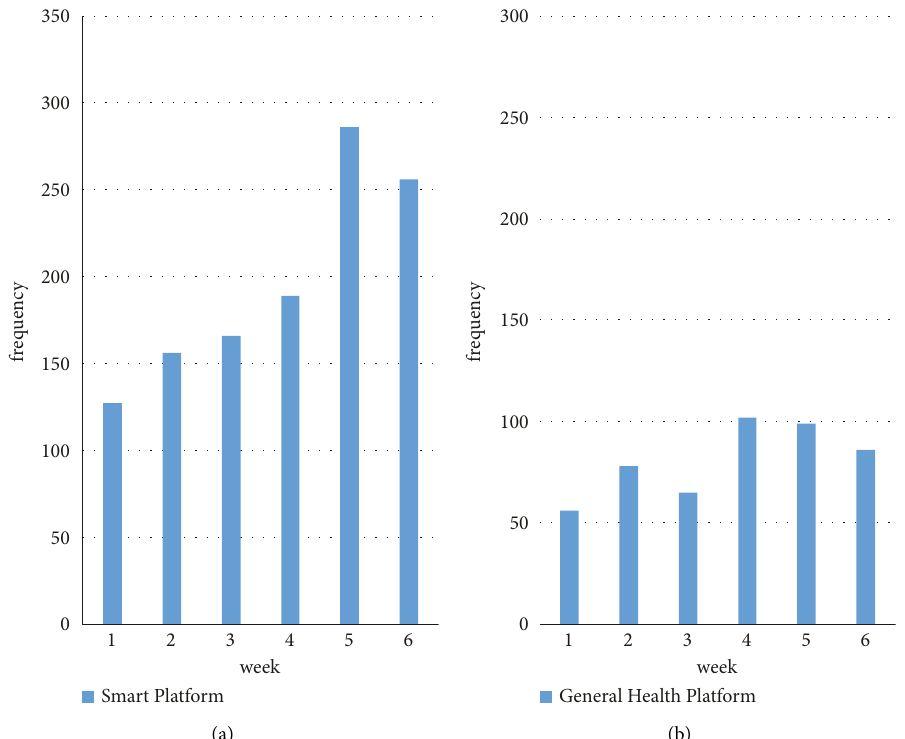
Figure 6: Comparison of registered numbers of TCM health platforms. (a) Number of registered smart health platforms. (b) General health platform registrations.